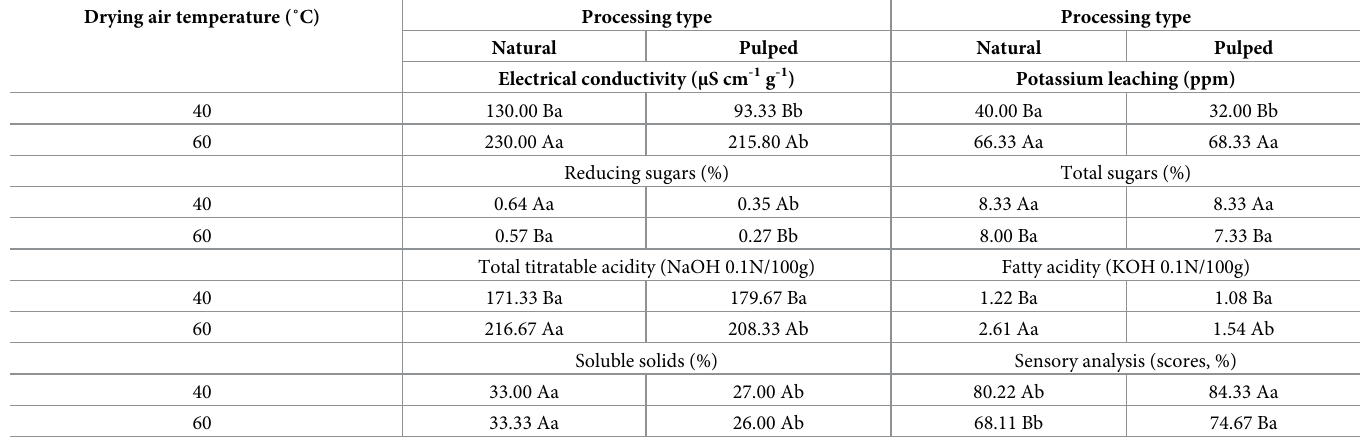
Means followed by the same lowercase letter in the row and uppercase letters in the column did not differ at 1 and 5%